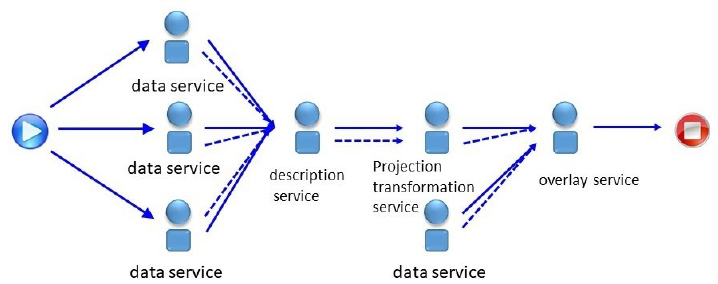
Figure 7. Data processing operation